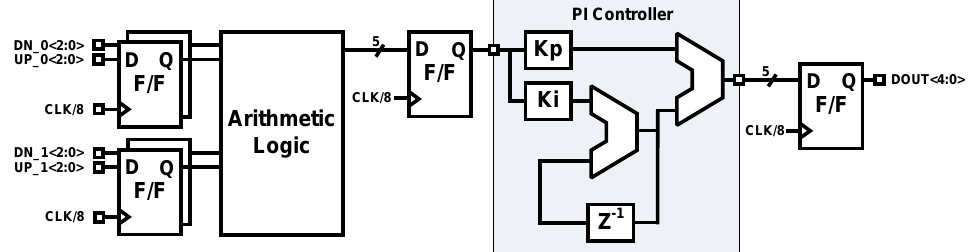
Figure 11. Simplified schematic of the PI-control digital loop filter.